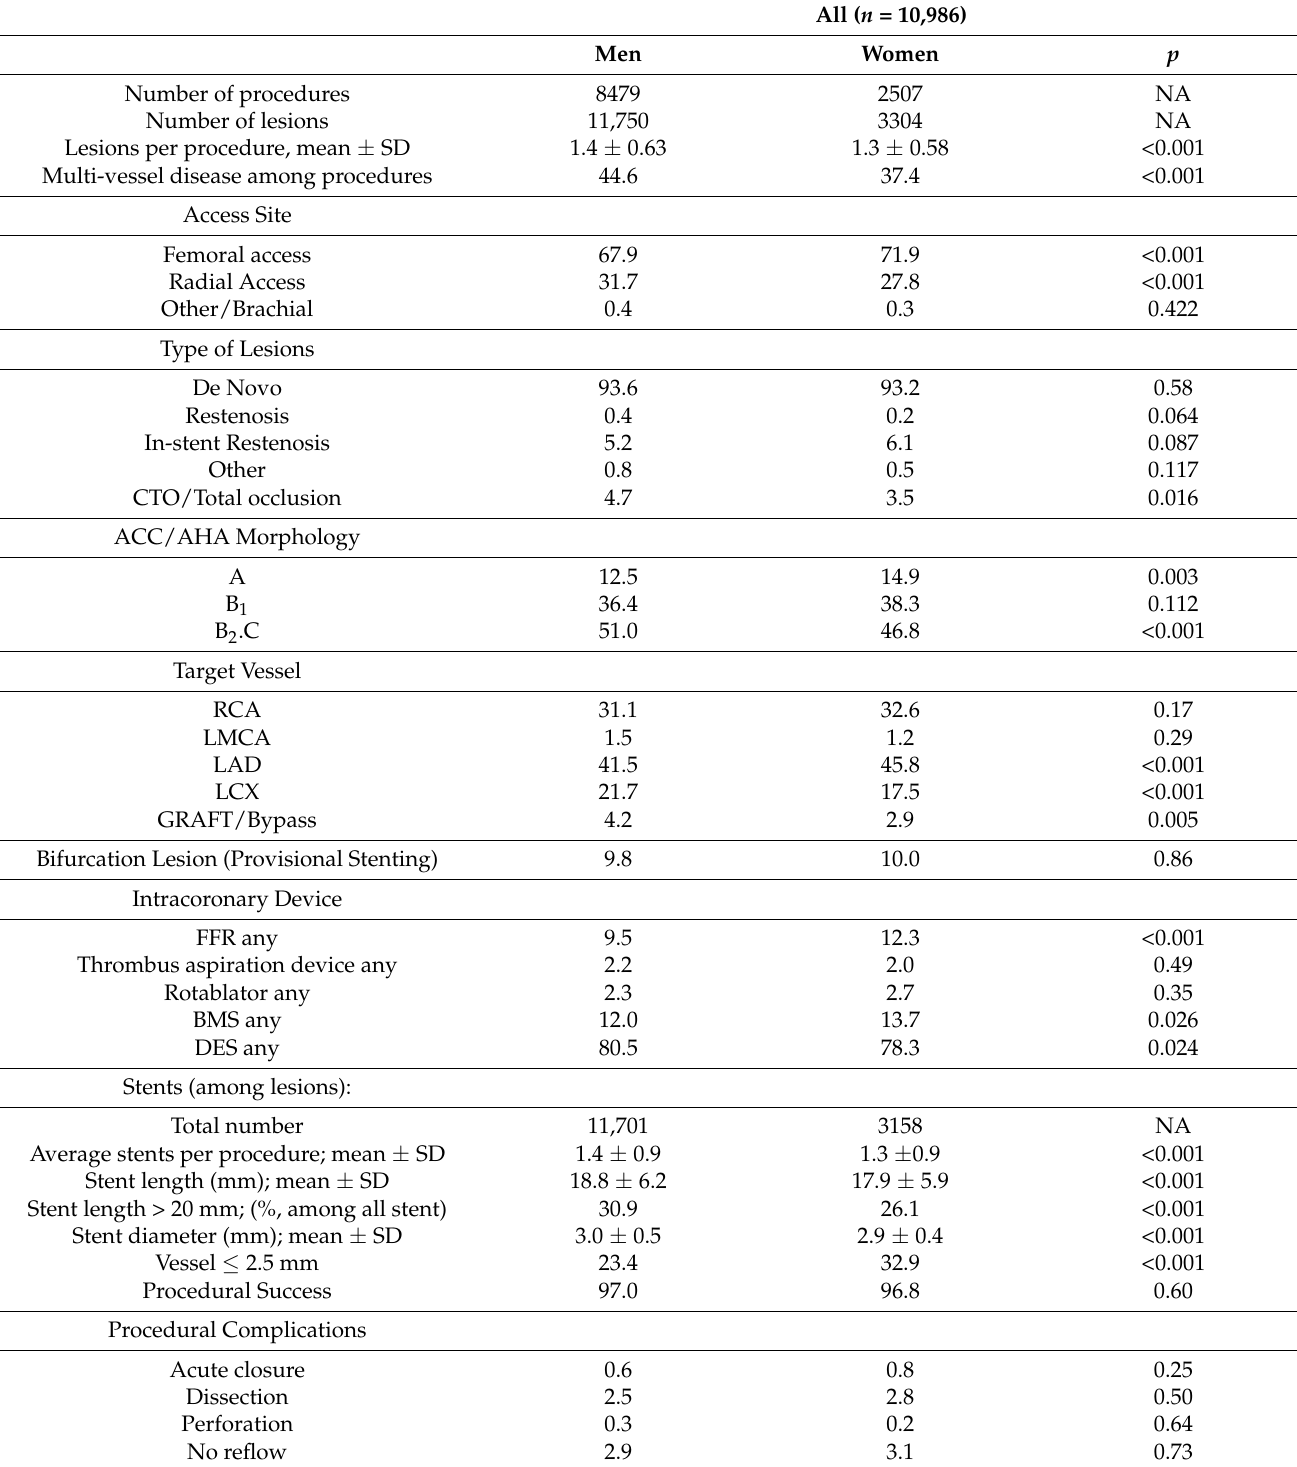
Table 2. Procedure and lesion